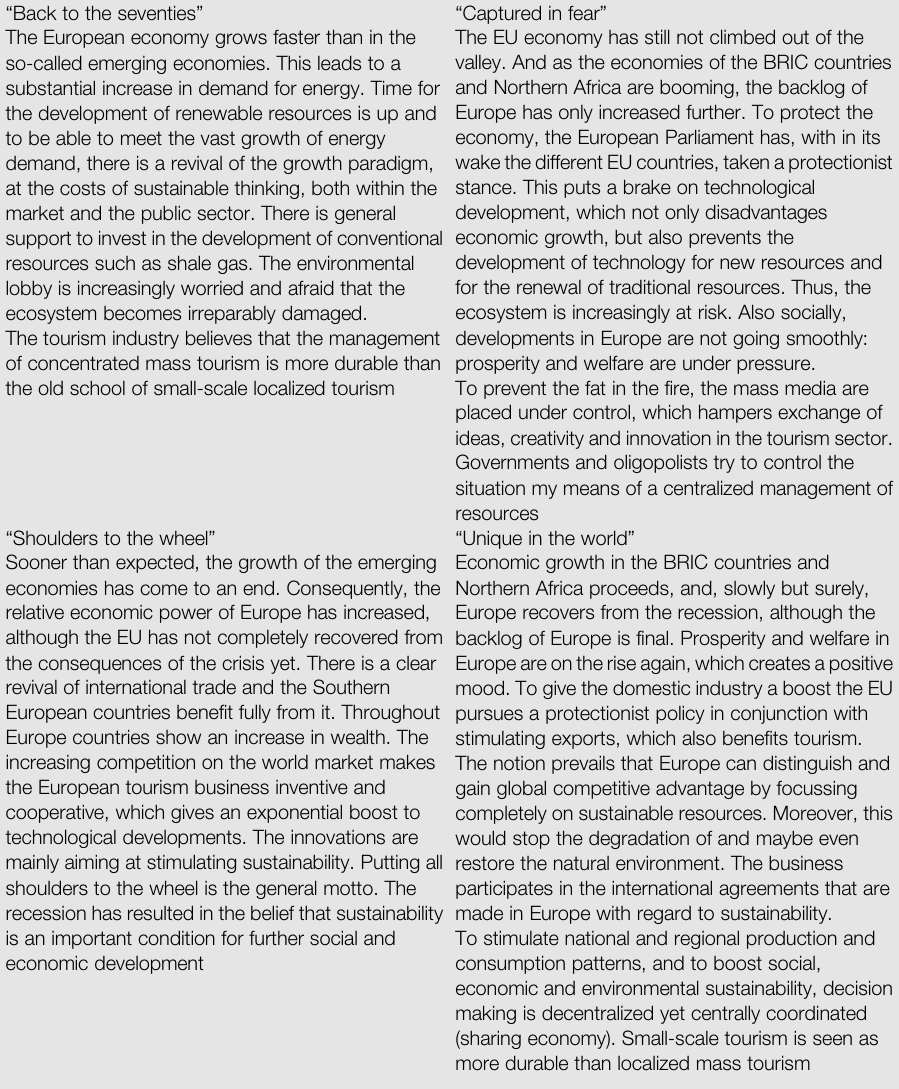
Table I Scenarios for a sustainable tourism industry by 2040 in detail “ Back to the seventies ” “ Captured in fear